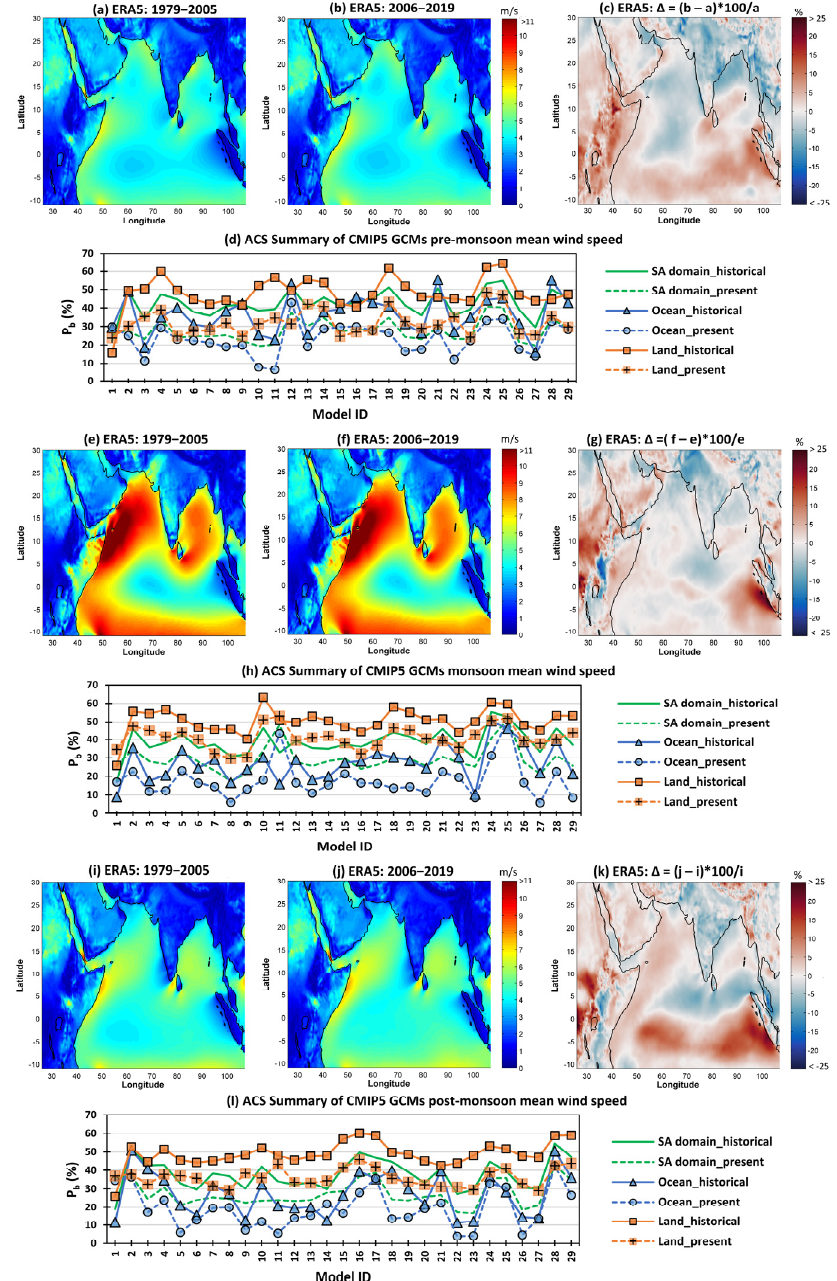
Figure 5. Pre ‐ monsoon (February − May) mean wind speed spatial maps of ERA5 for the ( a ) historical Figure 5. Pre-monsoon (February–May) mean wind speed spatial maps of ERA5 for the ( a ) historical (1979 − 2005) and ( b ) present time slice (2006 − 2019). ( c ) Percentage change of present time slice pre ‐ (1979–2005) and ( b ) present time slice (2006–2019). ( c ) Percentage change of present time slice pre- monsoon mean wind speed relative to historical time slice pre-monsoon mean wind speed ( ∆ , %). ( d ) As in Figure 2, but summarizes the climate model’s skill in simulating pre-monsoon mean wind speed; percentage of statistically significant bias (P b , %) on y-axis and Model ID on x-axis. ( e – h ) As in ( a – d ), but for monsoon season (June–September). ( i – l ) As in ( a – d ), but for post-monsoon season